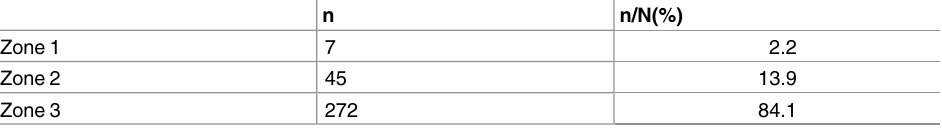
Table 1. Bradford’s Law of Scatteringfor journals thatpublished articleson regulatingT cell (Treg) research from 2000 to 2015.